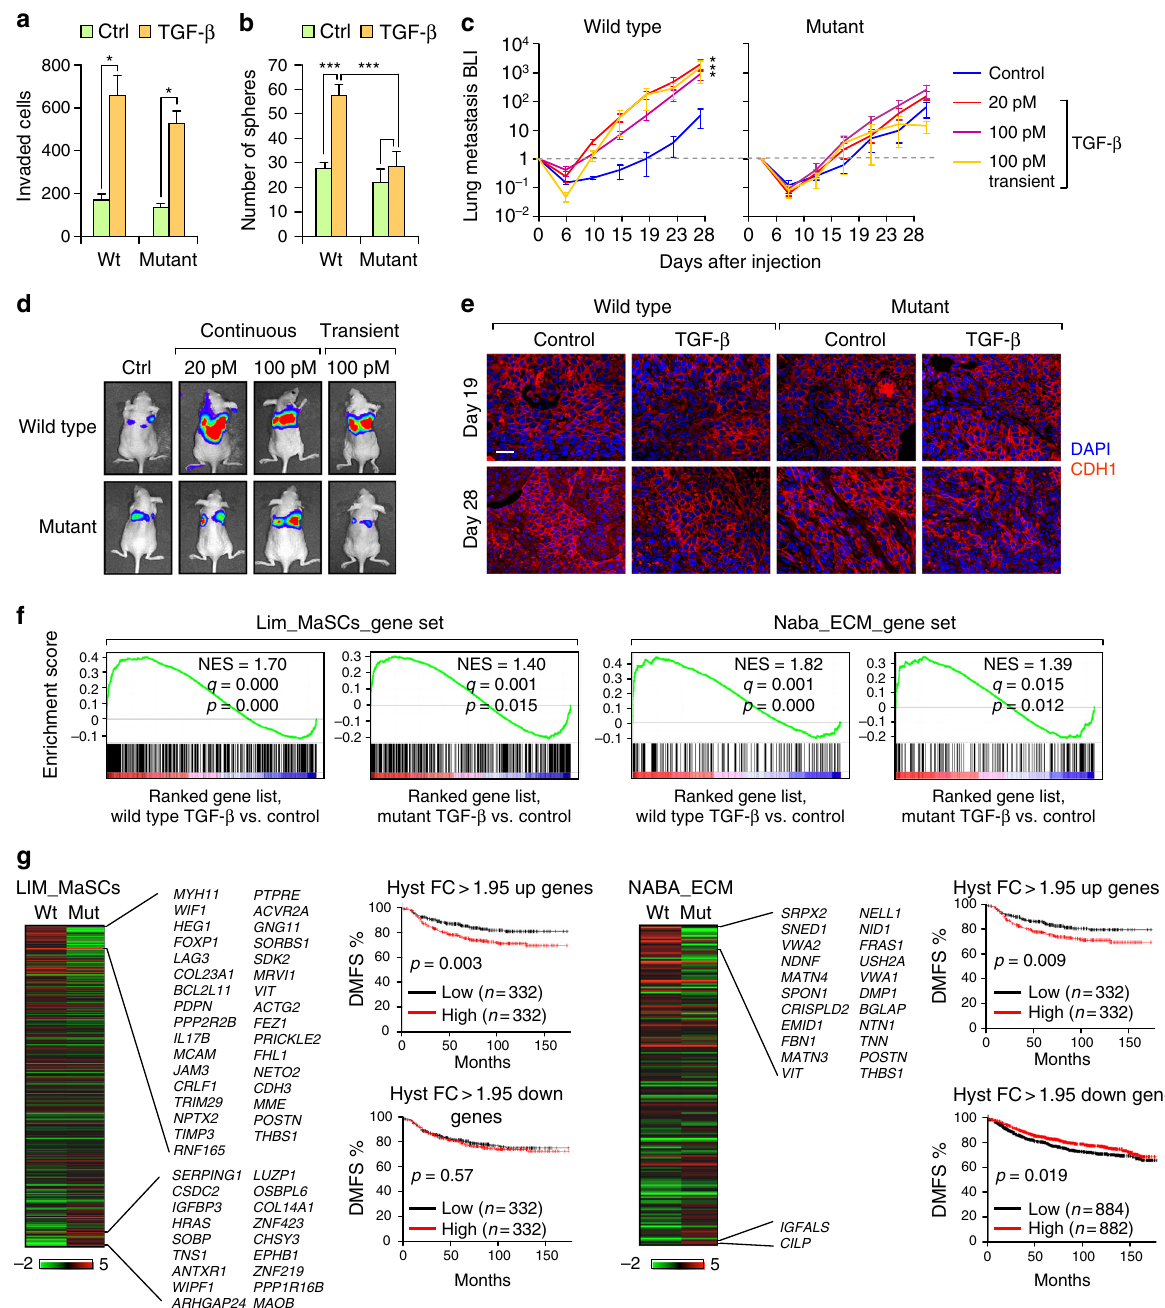
Fig. 5 Hysteresis during EMT increases the metastatic colonization ability of EpRAS cells. a Quanti fi cation of invading cells in Matrigel transwell invasion assays after 24 h of seeding 100,000 EpRAS cells with or without 100 pM TGF- β treatment. n = 3 biological replicates; data represents mean±SEM. b Quanti fi cation of mammosphere formation of 5,000 EpRAS cells with or without 100 pM TGF- β treatment. n = 4 biological replicates; data represents mean±SEM). c , d Bioluminescence imaging (BLI) quanti fi cation ( c ) and representative images ( d ) of the metastatic growth of the EpRAS wild type and mutant cells in the lungs after tail vein injection of 20,000 cells in Ncr-nu/nu mice ( n = 6 mice). EpRAS cells were treated with the indicated concentration of TGF- β for 72 h (continuous) or 5 min followed by 72 h withdrawal (transient) prior to injection. Data represents mean±SEM. e Confocal microscopy imaging of CDH1 staining of lung metastatic tumor tissue. Wild type and mutant EpRAS cells were injected at the indicated conditions. Lung metastasis sample collection was done at the indicate time points after tail vein injection. Scale bar: 25 μ m. f GSEA demonstrating the enrichment of the gene sets from the MSigDB related to mammary stem cells (Lim_MaSC_M2573) 50 ) and ECM (Naba_ECM-GLYCOPROTEINS_M3008) in the ranked gene list of TGF- β treated vs. control conditions in wild type or mutant EpRAS cells. NES, normalized enrichment score. g Heatmap of differentially expressed genes in Lim_MaSC (left) and Naba_ECM-GLYCOPROTEINS datasets (right); color legend represents Log2 fold change (FC). Genes highlighted are genes with a >1.95 fold change (FC) during EMT in wild type but are not signi fi cantly changed in during EMT in mutant EpRAS cells. Kaplan – Meier distant metastasis free survival (DMSF) curves of breast cancer patients in the composite KM plotter breast cancer clinical database 36 with higher or lower than median expression levels of the indicated gene sets were shown in the right side of the heatmap. * P < 0.05, ** P < 0.01, *** P < 0.005 by two-tailed Student ’ s t -test